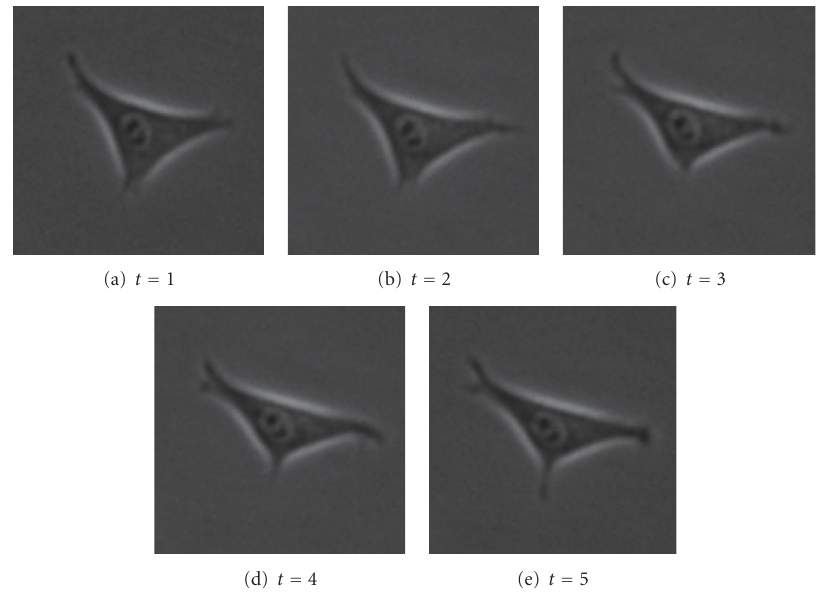
Figure 15: Original image sequence.